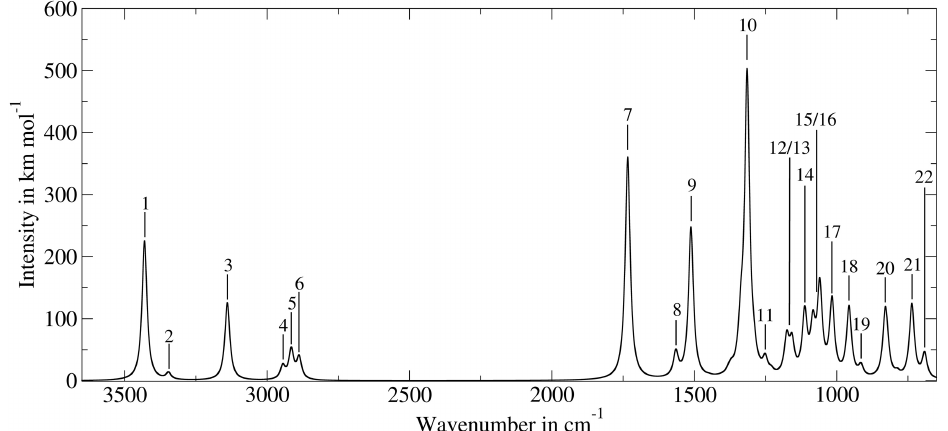
Figure 2. The computed IR spectrum of [pSer-H] − . For band assignments, refer to Table